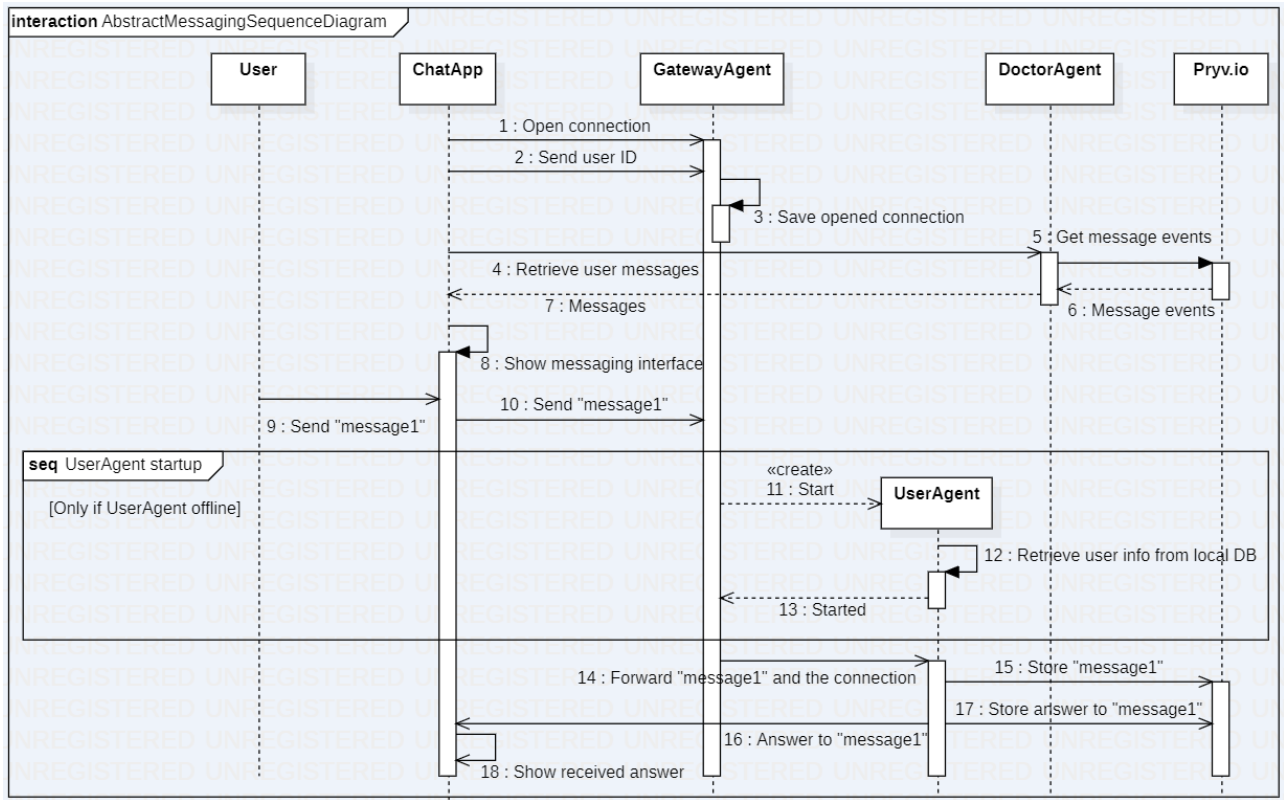
Figure 14. Messaging process interaction